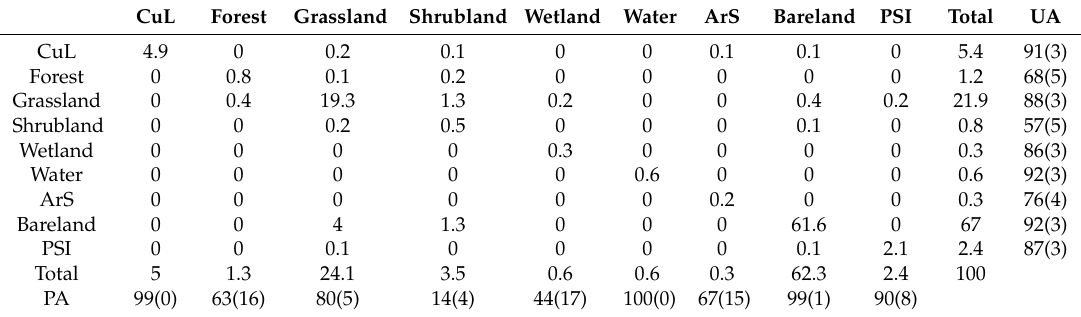
Table A1. The error matrix of estimated area proportions for R1: Overall accuracy is 90.3% (2.0%). CuL Forest Grassland Shrubland Wetland Water